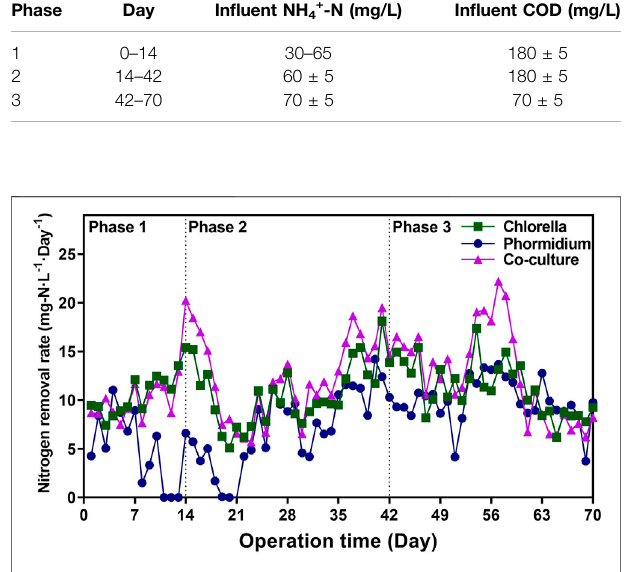
FIGURE 1 | Nitrogen removal rates of different reactors in three phases.